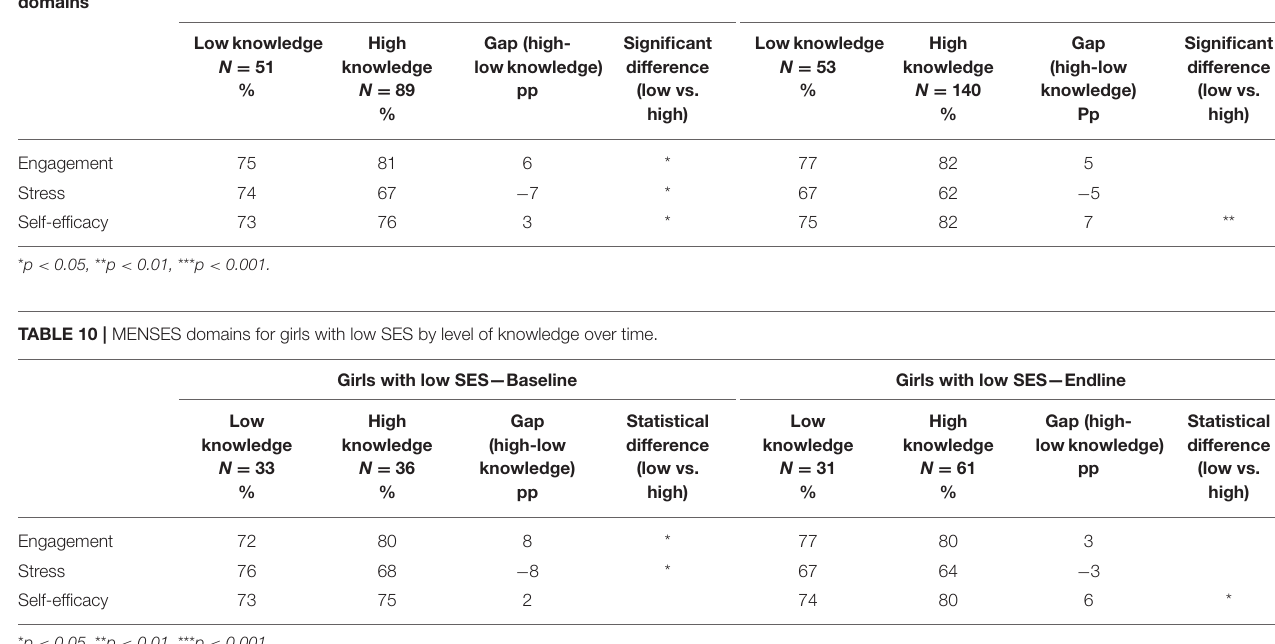
Significant difference (low vs. high)